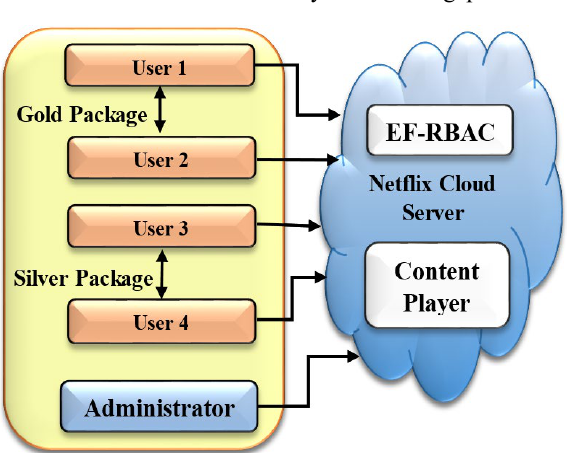
Figure 5. Netflix Cloud Management